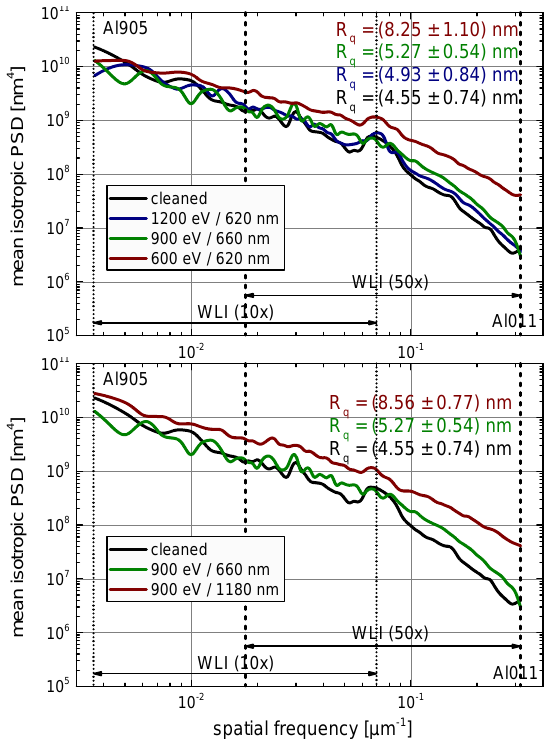
Figure 2. PSD functions before and after RIBE processing with nitrogen gas. Surface degradation increases at lower ion energies (upper) and for increased process time and thus depth (lower).